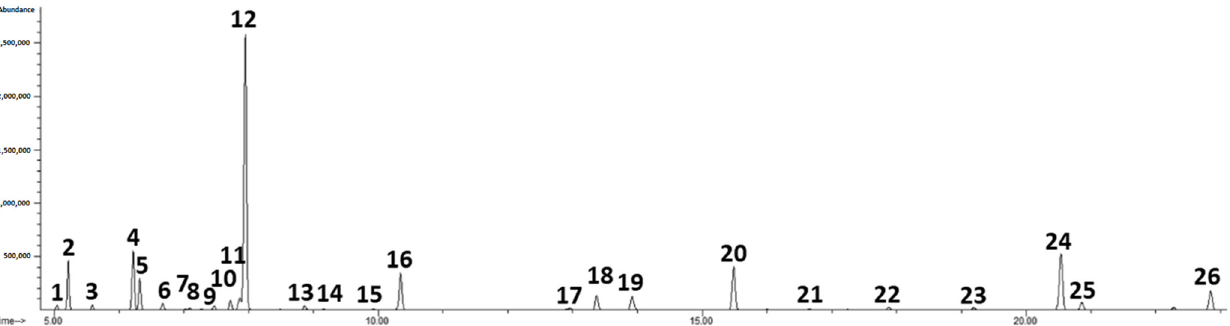
Figure 1. Chromatogram of volatile compounds of laurel essential oil (1 = α -thujene; 2 = α -pinene; 3 = camphene; 4 = sabinene; 5 = β -pinene; 6 = myrcene; 7 = α -phellandrene; 8 = 3-carene; 9 = α -terpinene; 10 = p -cymene; 11 = d-limonene; 12 = eucalyptol; 13 = γ -terpinene; 14 = cis -sabinene hydrate; 15 = α -terpinolene; 16 = linalool; 17 = δ -terpineol; 18 = terpinen-4-ol; 19 = α -terpineol;